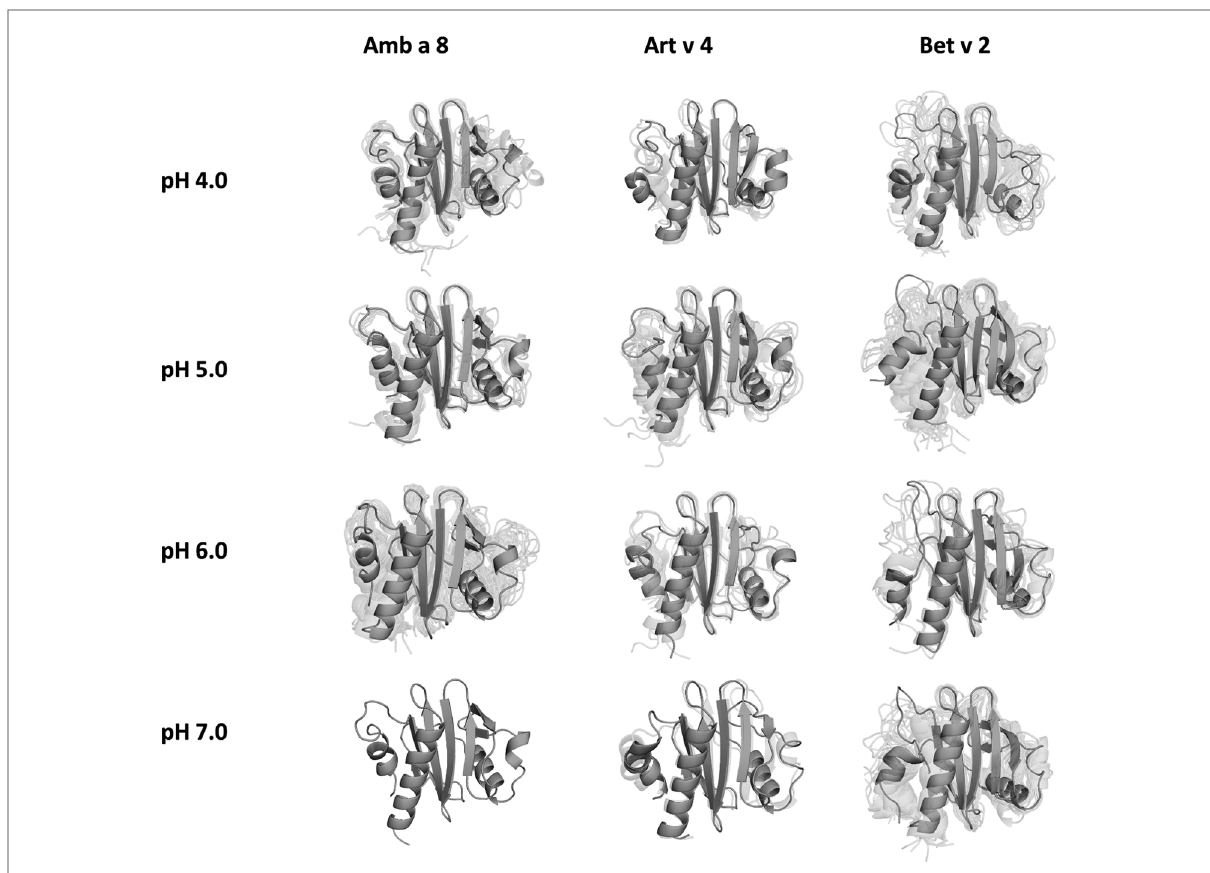
FIGURE 4 Representative conformational ensembles obtained by clustering the GaMD simulations at different pH values with the same clustering distance cut-off